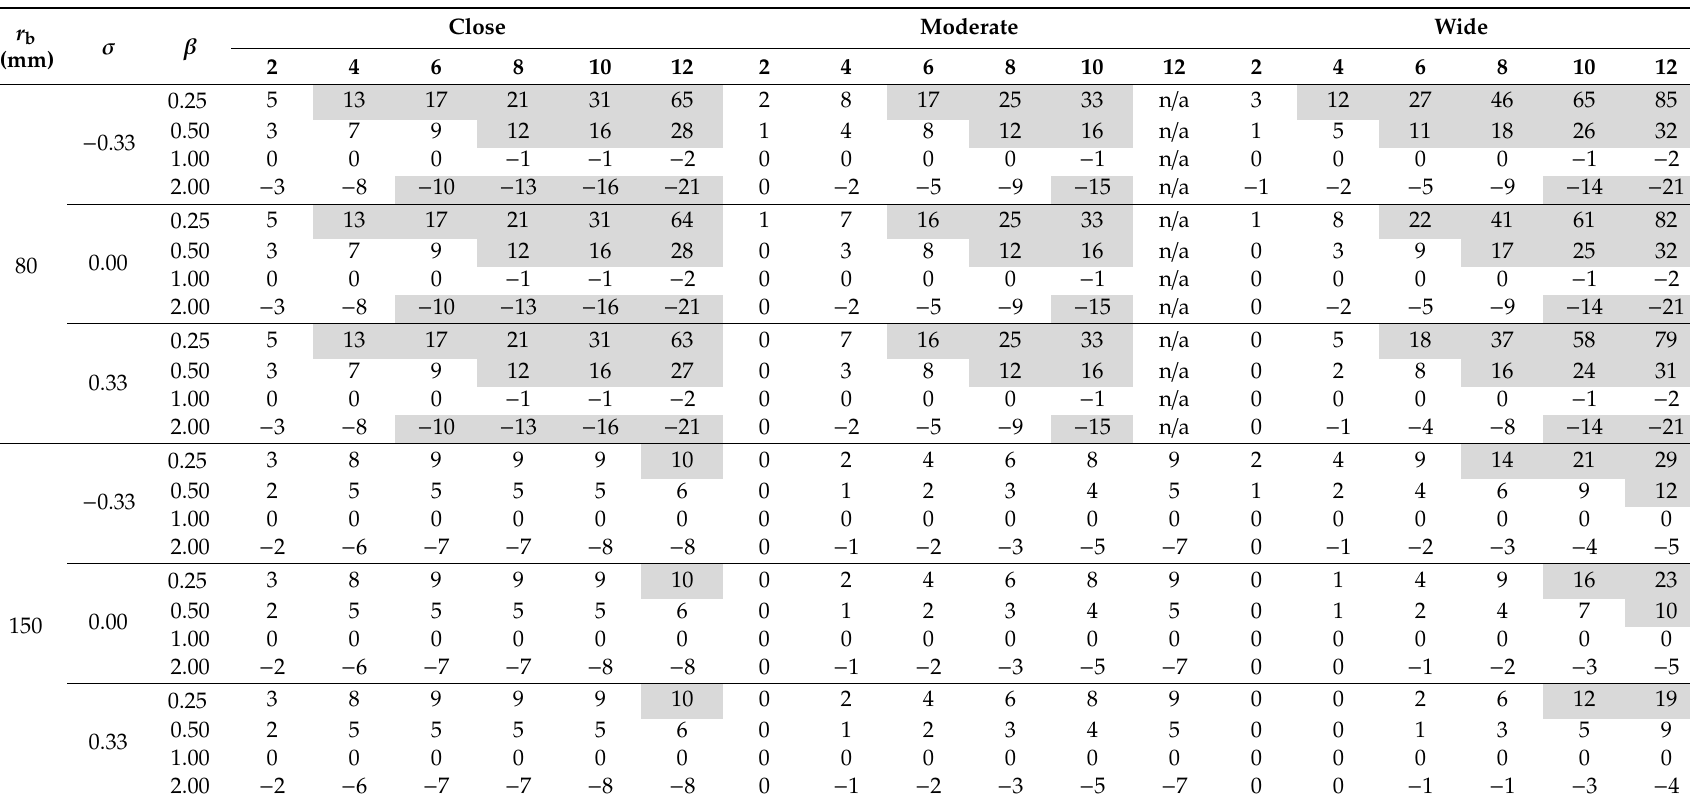
Table 1. Relative error ∆ R b0 ( N , r b , r c , r p , σ , β ) in percent for N = 2 to 12, and r c = r c,min (close spacing), 2 r b / 3 (moderate spacing), and r b − r p (wide spacing) a . The pipe radius r p is 0.016